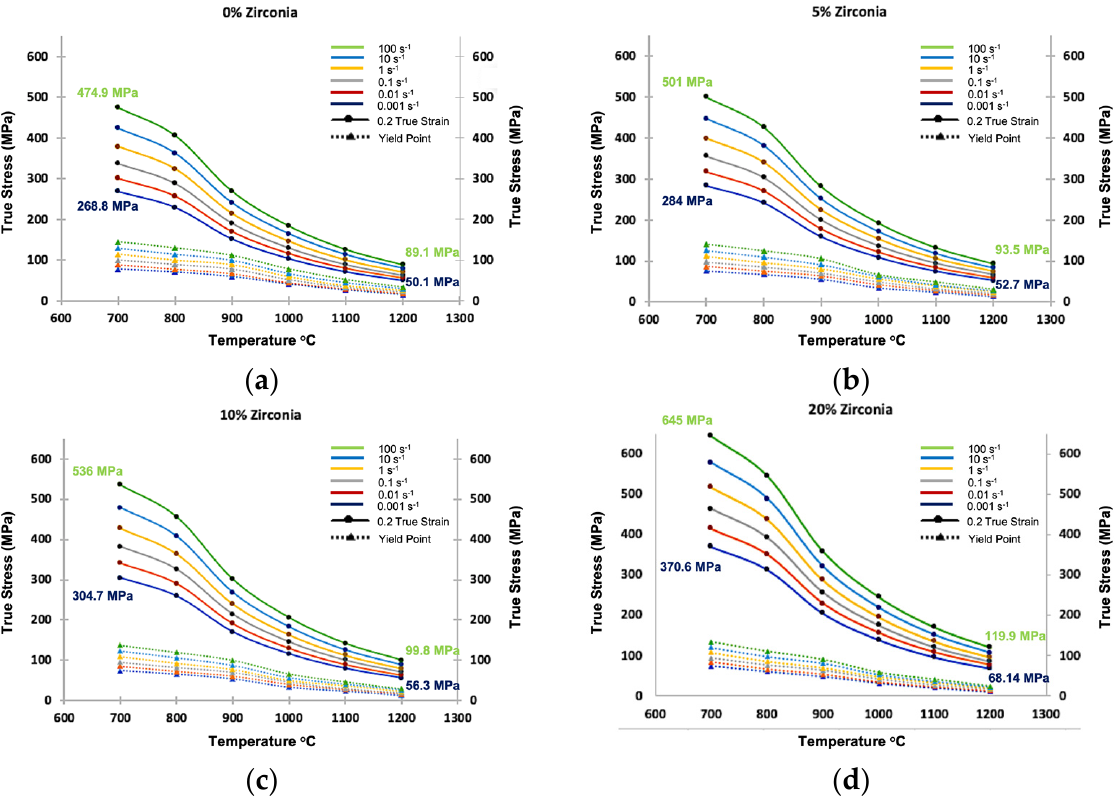
Figure 7. Comparison of flow stress values in MPa based on the simulation results at the yield point and 0.2 deformation for composites with ( a ) 0% zirconia, ( b ) 5% zirconia, ( c ) 10% zirconia, and ( d ) 20% zirconia particles.